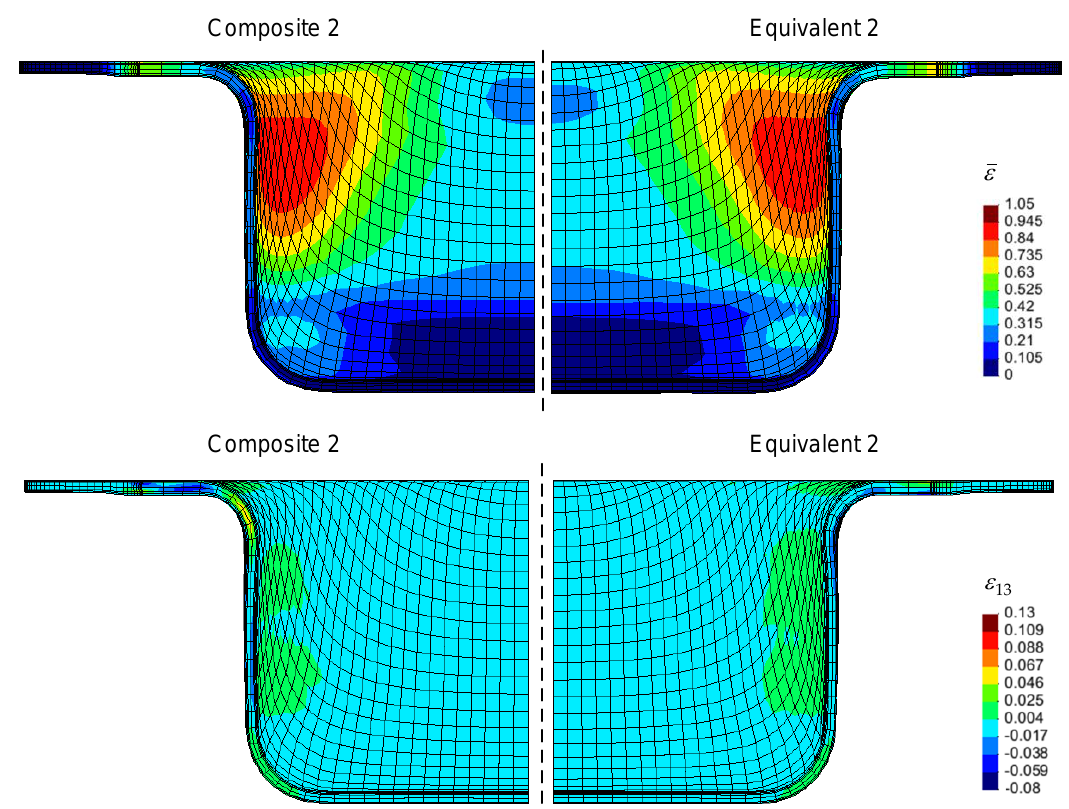
Figure 15. Side view of equivalent plastic strain distributions, ε̅ , and Green–Lagrange shear strain, 𝜀 13 , in the Composite 2 and corresponding equivalent material, at the end of the deep drawing process for BHF = 4.9 kN. The maximum values of 𝜀̅ and 𝜀 13 are, respectively: 1.024 and 0.121 (for Composite 2); 1.037 and 0.069 (for Equivalent 2).